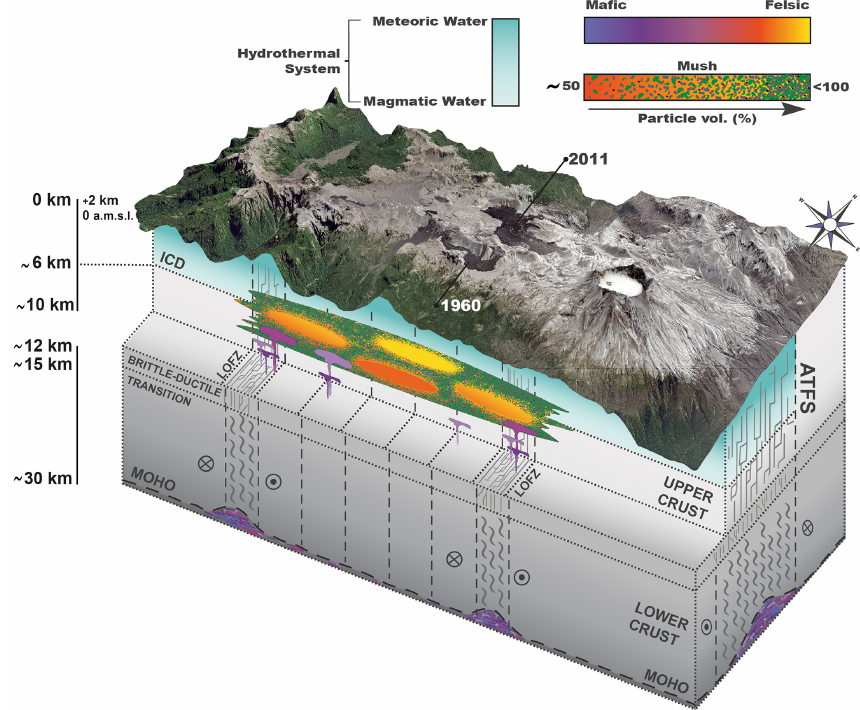
Figure 9. Schematic representation of the crustal structure underneath Puyehue–Cordón Caulle Volcanic Complex. This includes the vertical stratification of the crust and the occurrence of main fault systems (Liquiñe–Ofqui Fault Zone, LOFZ, and Andean Transverse Fault System, ATFS). See Sect. 5.1 for a description and the sources of the